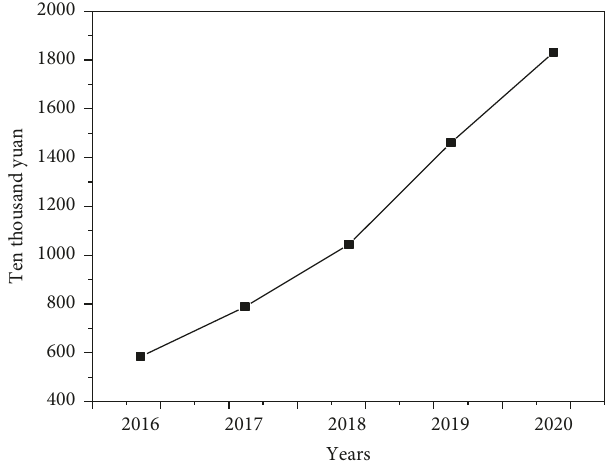
Figure 10: Operating revenue of CW company from 2016 to 2020.